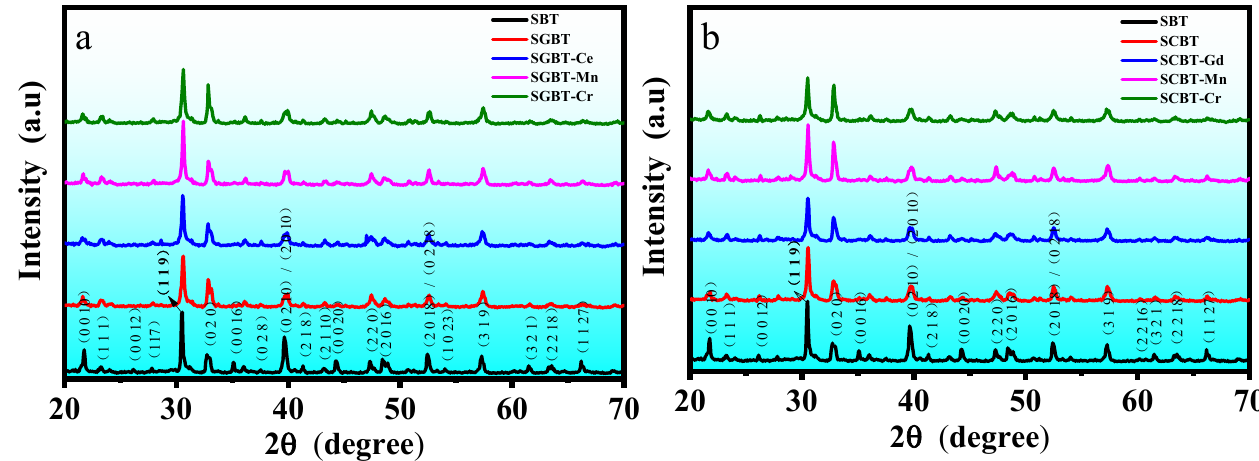
Figure 2. XRD patterns of the oxide-modified SBT ceramics: ( a ) SGBT-series; ( b ) SCBT-series. The lattice parameters of the oxide-modified SBT ceramics are given in Table 1. The lattice parameters ( a , c and v ) of the oxide-modified SBT decrease, whereas the values of orthorhombic distortion ( b / a ) increase, which may be attributed to the ion-substitution effect caused by the addition of different oxides. The bismuth oxide layer is very strong and bismuth ion in the bismuth oxide layer are difficult to be substituted by other ions [32], meanwhile ions with similar ionic radius and same coordination number are more likely to be mutually substituted [31], consequently Sr 2+ located at the A-site in the perov- skite layers are substituted by Gd 3+ /Ce 4+ with smaller ion radius. Ti 4+ located at the B-site in the perovskite layers would be substituted by Mn 3+ and Cr 3+ . The lattice distortion caused by ion substitution can result in the change of electrical properties for ferroelectric compounds [33]; the larger b / a value is, more distorted the lattice is. Among these compo- sitions, the unit cell of SGBT-Cr has the largest orthorhombic distortion with a b / a value of 1.0024. Table 1. Lattice parameters of the oxide-modified SBT ceramics.